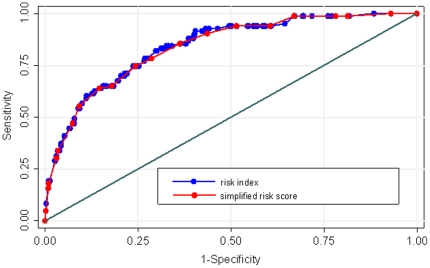
Receiver operating characteristics (ROC) of the risk index and the simplified risk score in the first cohort.